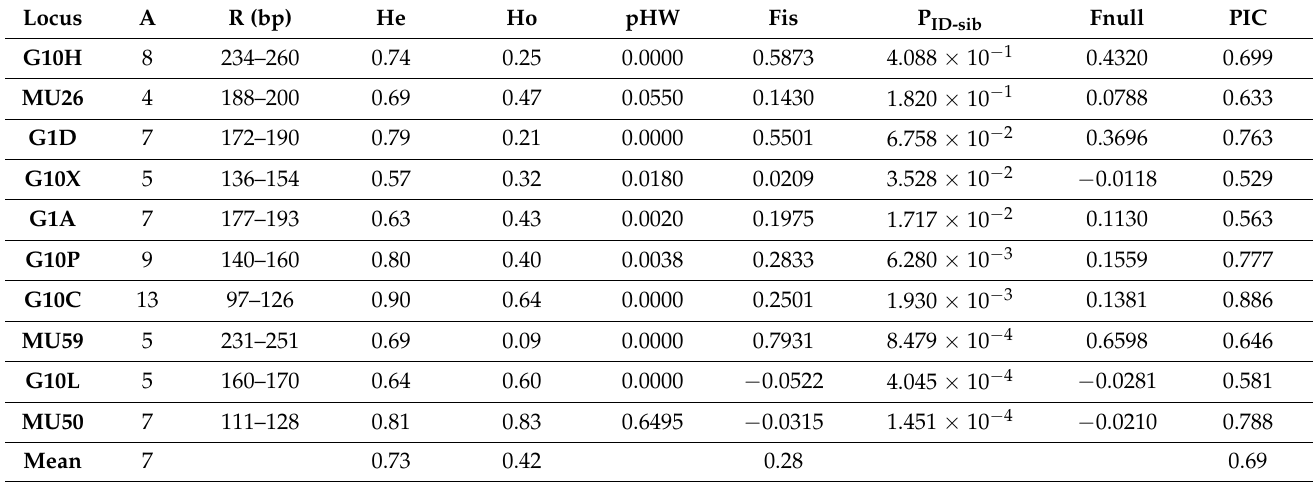
Table 3. Genetic information of the brown bear population from Prespa NP. Number of alleles (A); allele size per bp (R); expected heterozygosity (He); observed heterozygosity (Ho); p -value for Hardy–Weinberg Equilibrium (pHW); inbreeding coefficient (Fis); probabilities of identity (P ID-sib ); frequency of null alleles (Fnull); polymorphic information content (PIC).